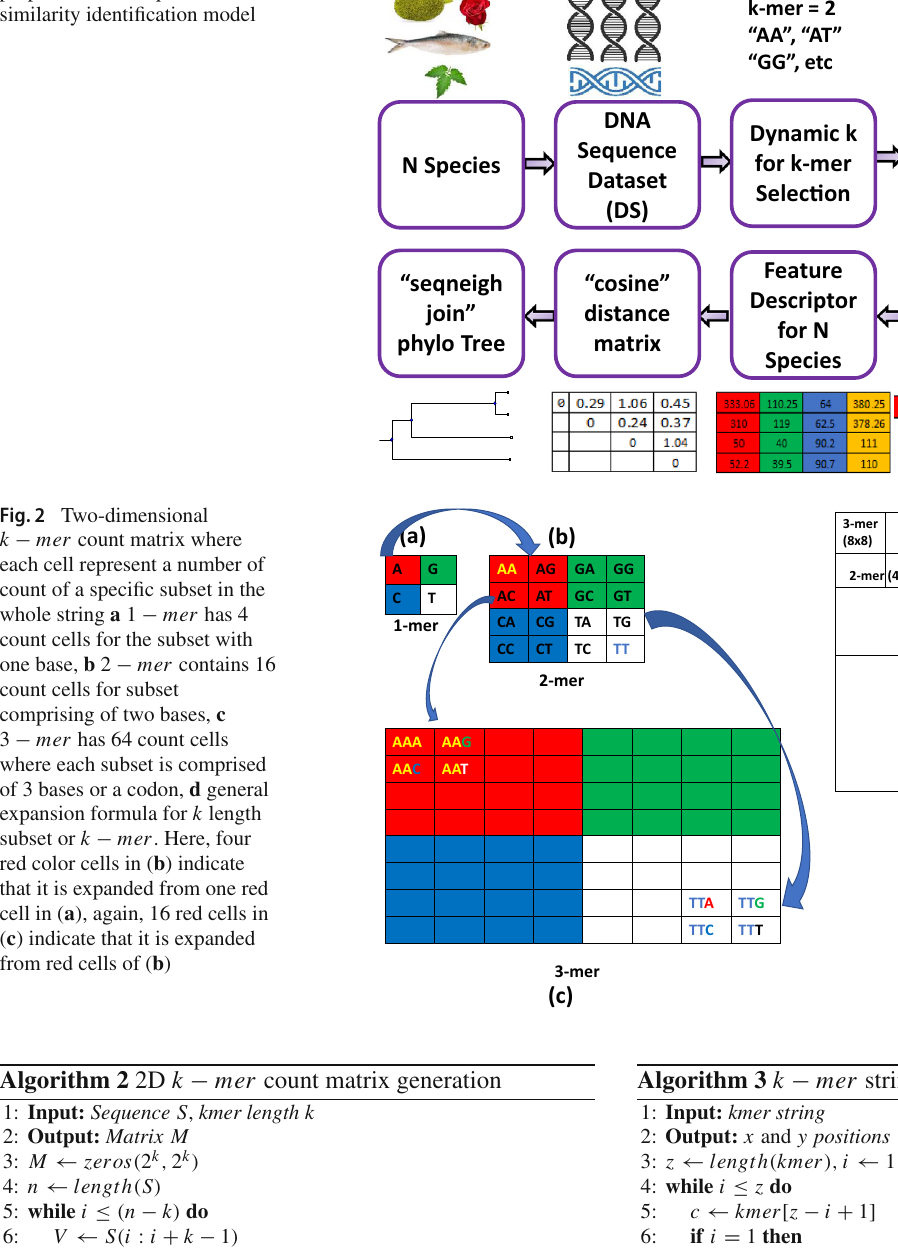
Fig. 1 Overview of our proposed DNA sequence